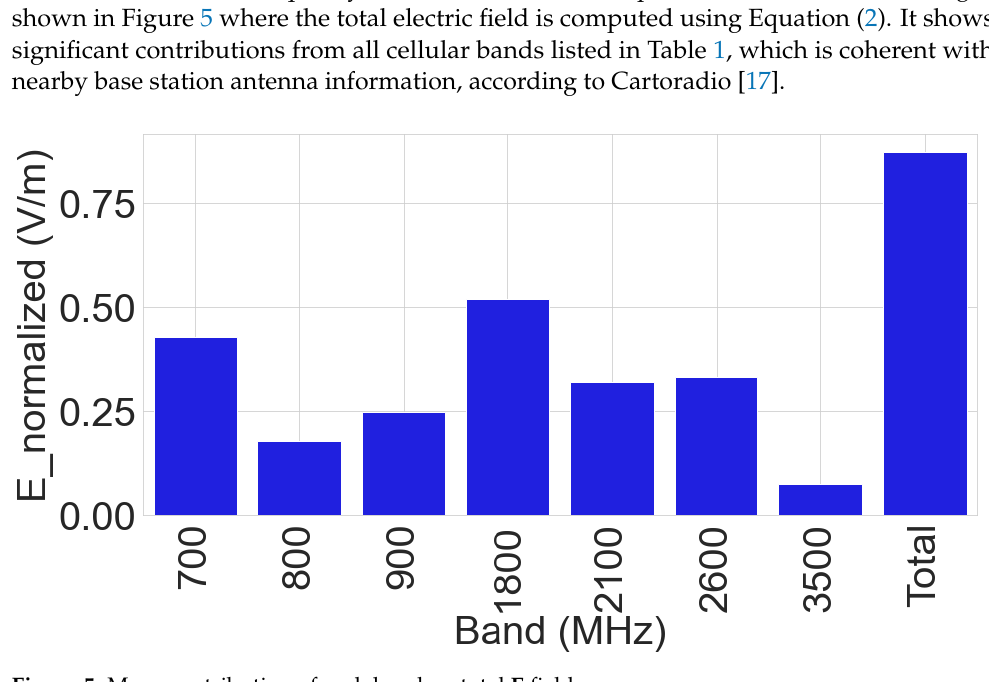
Figure 5. Mean contribution of each band on total E